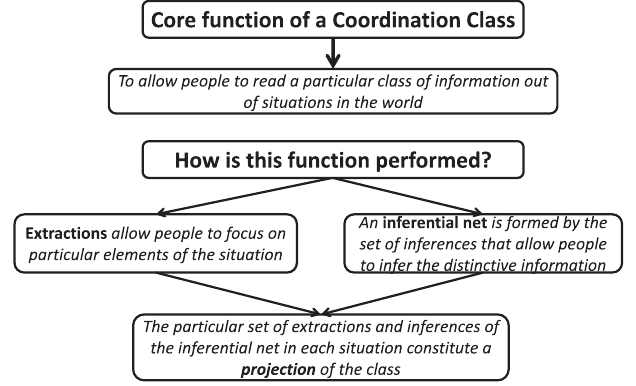
FIG. 1. Schematic representation of theoretical elements that constitute a coordination class.